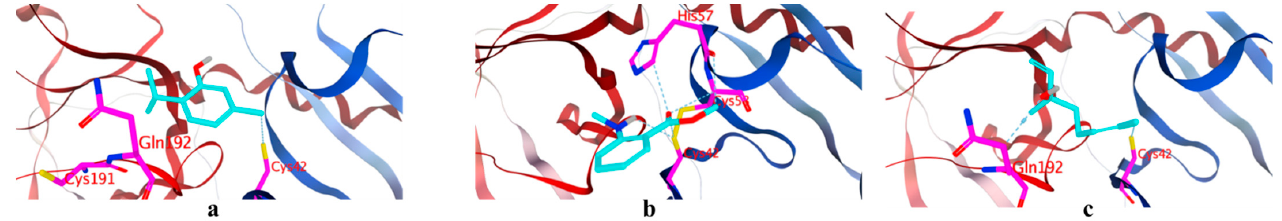
Figure 6. Binding modes of thymol ( a ), dimethyl anthranilate ( b ), and linalool ( c ) with elastase.